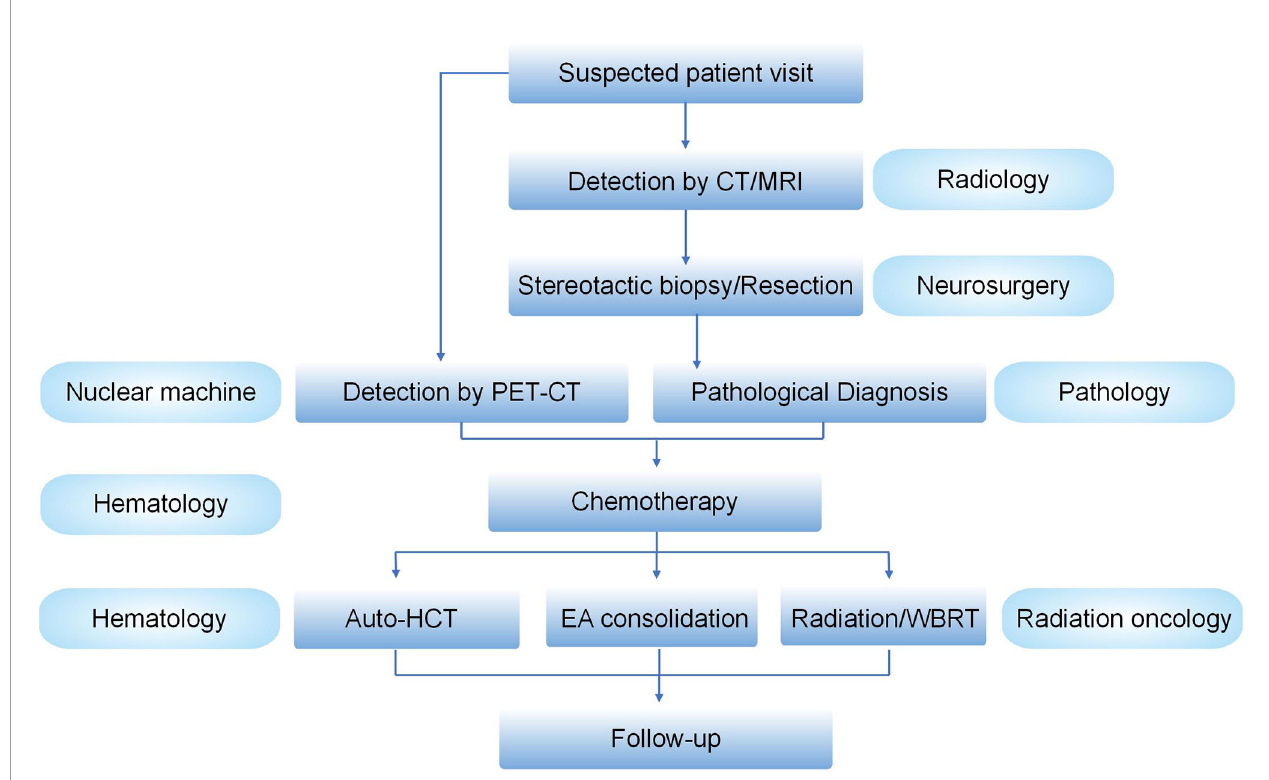
FIGURE 1 | Management schedule for an experienced MDT for PCNSLs. Suspected PCNSL patients visit the clinics, followed by the detection of brain by CT/MRI. If there is a preferred mass in the brain, the patients will receive stereotactic biopsy or resection by neurosurgery. The pathological diagnosis will be made by the Department of Pathology. PET/CT will be mainly used to differentiate the PCNSL from secondary CNSL. After that, the condition of the con fi rmed patients will be further evaluated and the precise treatment will be discussed by hematologists and irradiation oncologists in an MDT meeting. After the treatment, patient follow-up will be